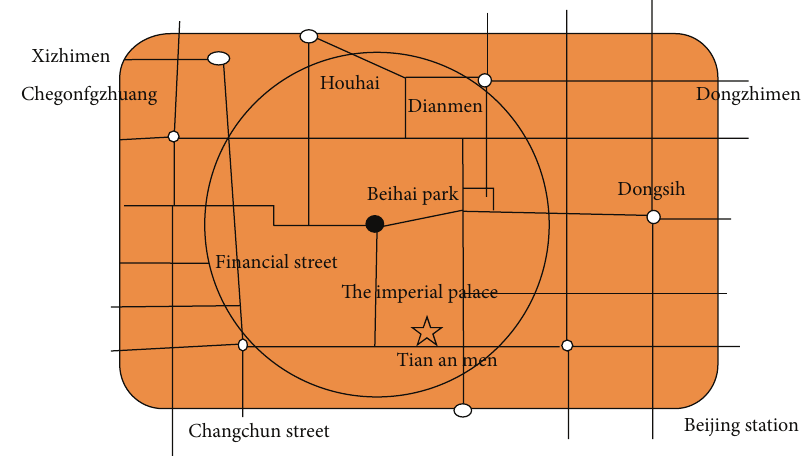
Figure 2: Route network of Beijing’s second ring road.